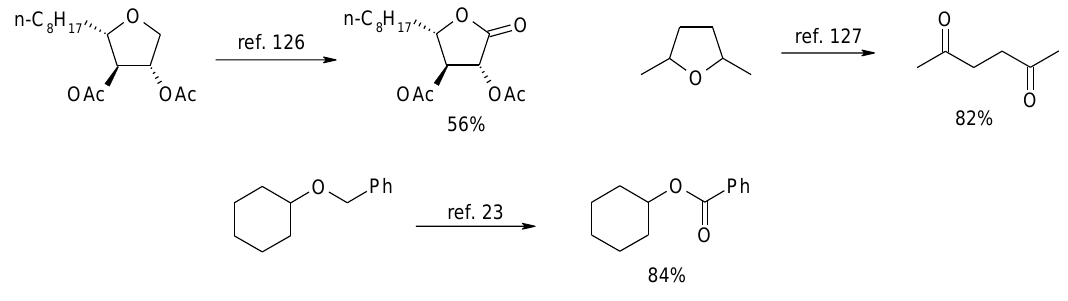
-catalyzed oxidation of 4